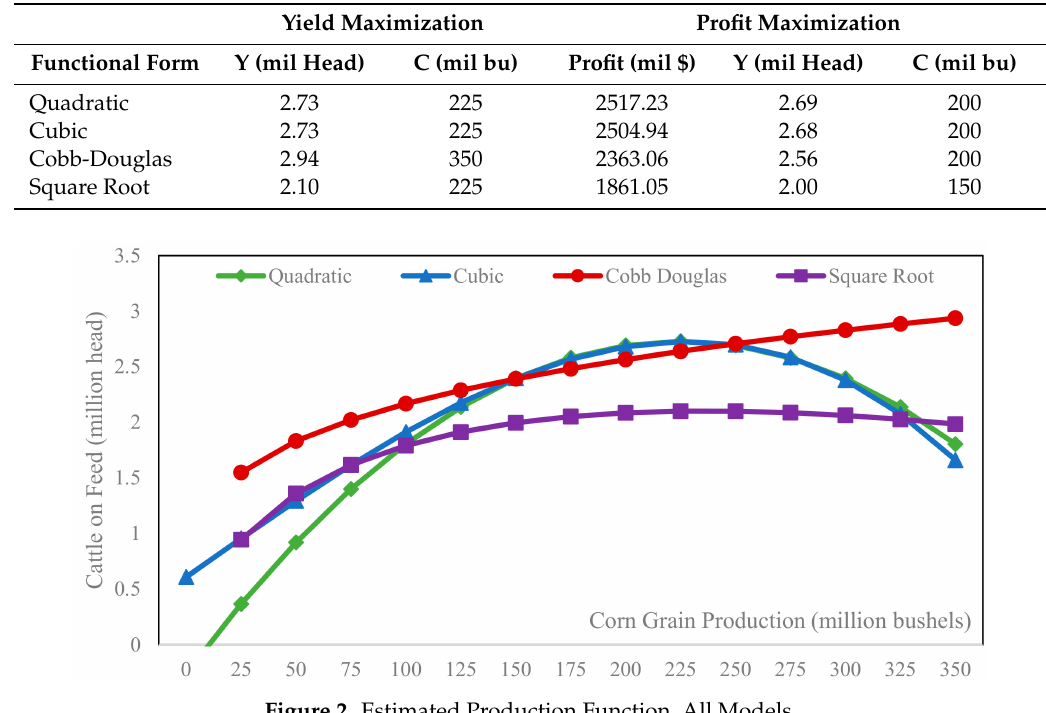
Figure 2. Estimated Production Function, All Models.